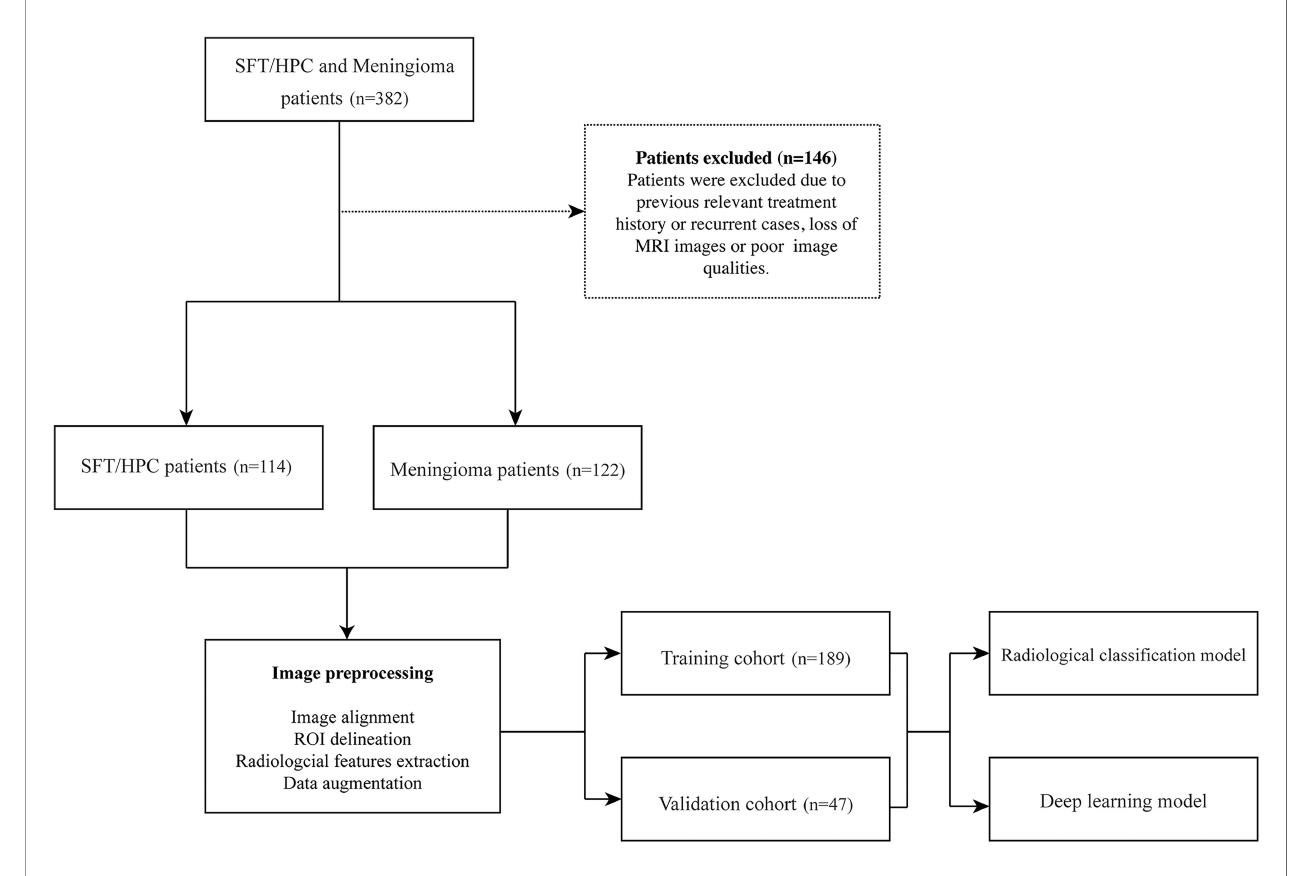
FIGURE 1 | Flowchart of the whole